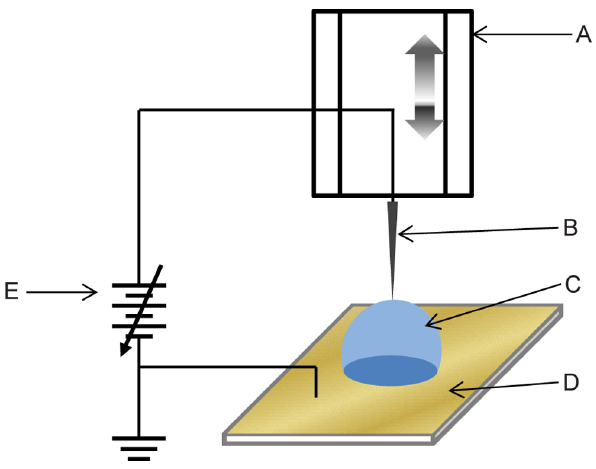
Figure 2. CNT fibril annealing setup. (A) A motorized linear stage moving only in the vertical direction. (B) A CNT probe. (C) Water droplet. (D) Gold plated surface for grounding. (E) Variable DC voltage source.